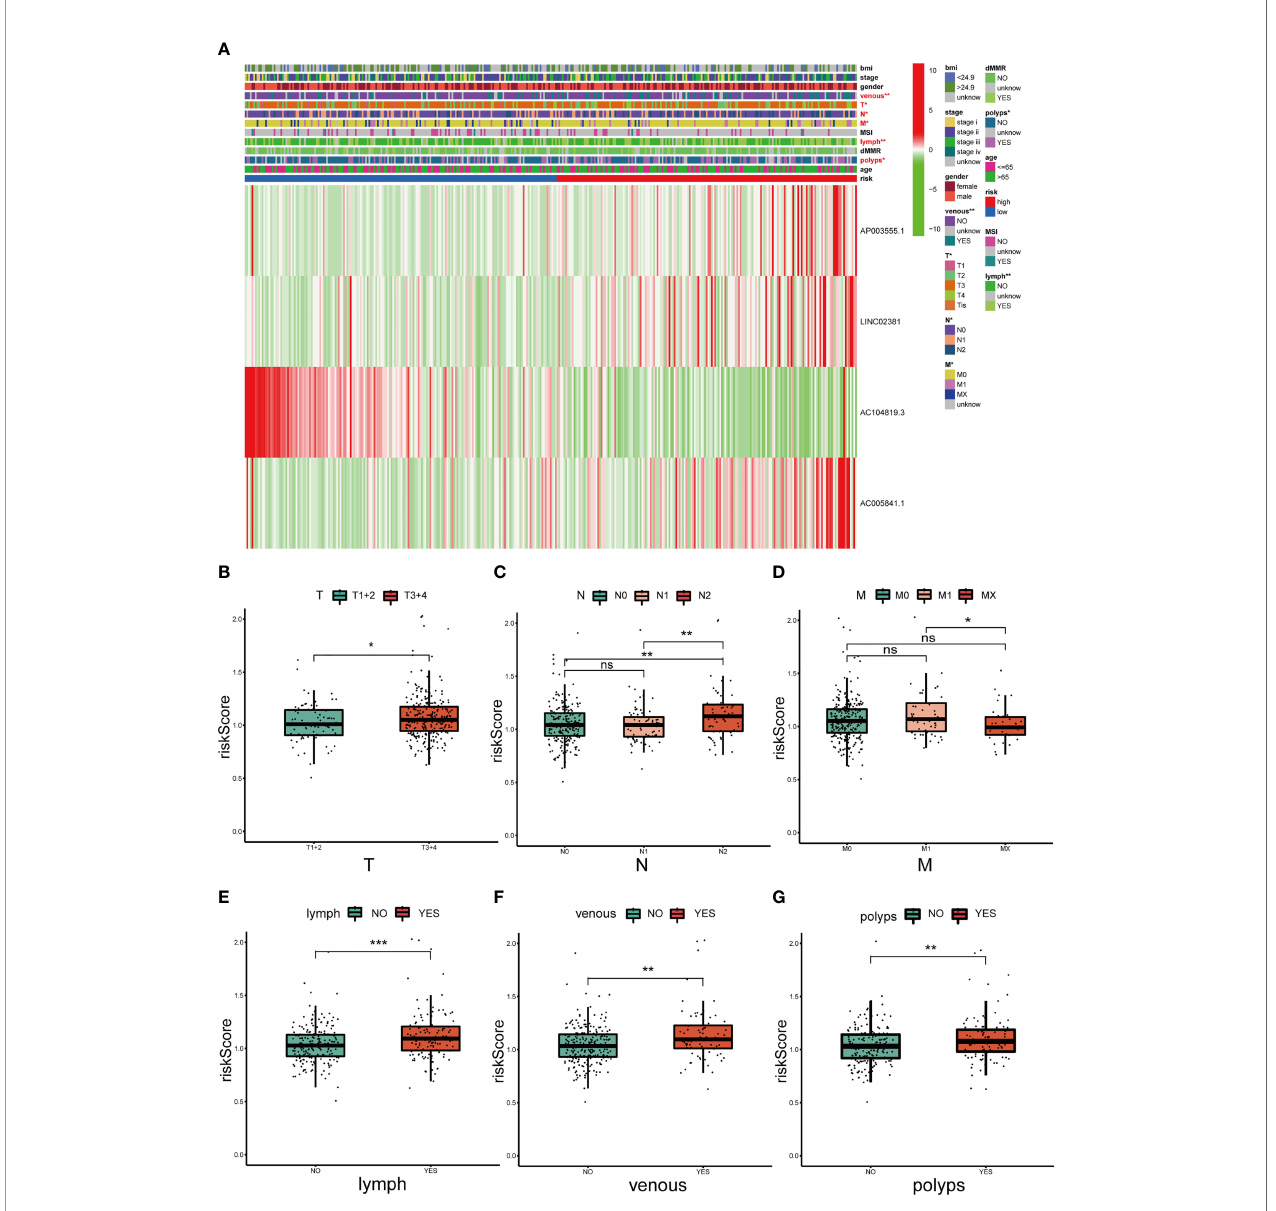
FIGURE 5 | Correlation analysis between the prognostic signature and different clinicopathological characteristics in the TCGA cohort. (A) The heatmap depicting the distribution of 12 different clinicopathological characteristics with the risk scores of each patient based on the signature. (B – G) The histogram depicting the signi fi cant difference of the risk scores in colon cancer patients strati fi ed by T stage, N stage, M stage, lymph invasion, venous invasion and polyp history. *p < 0.05, **p < 0.01, and ***p < 0.001. ns, No signi fi